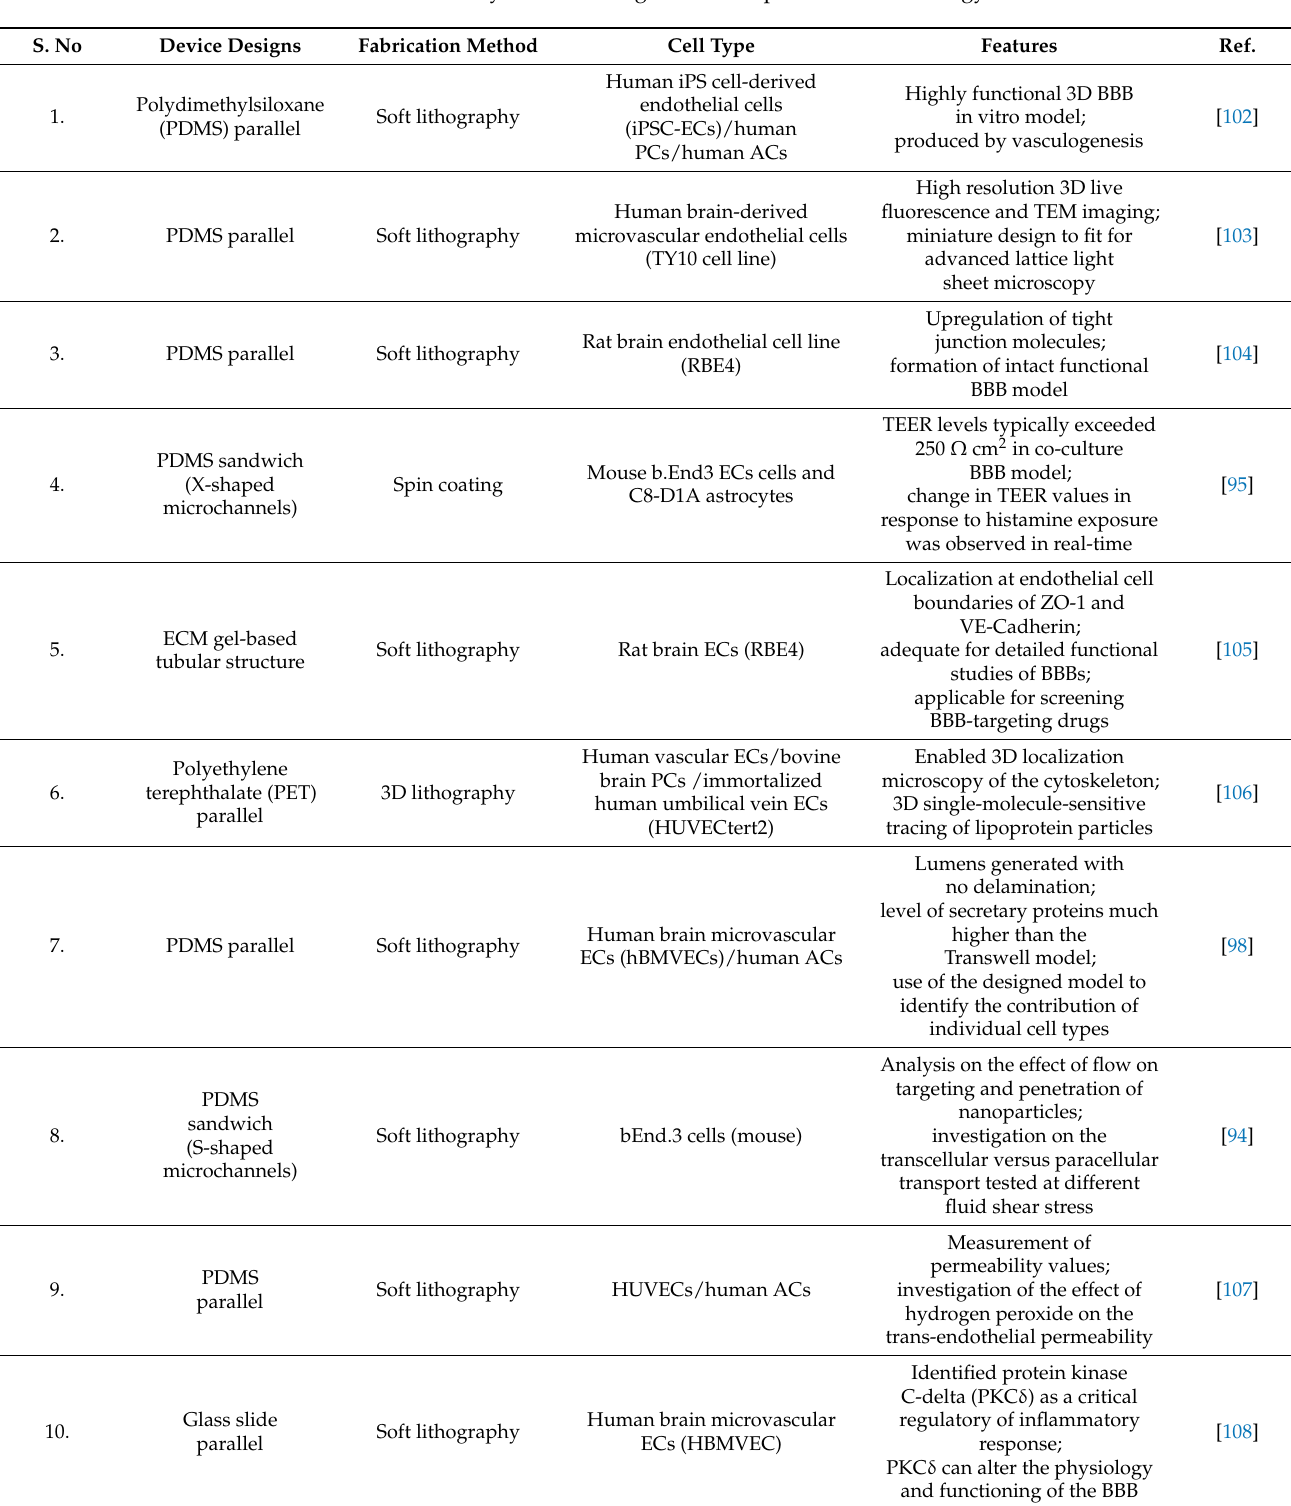
Table 1. Summary of the existing BBB-on-chip models for oncology